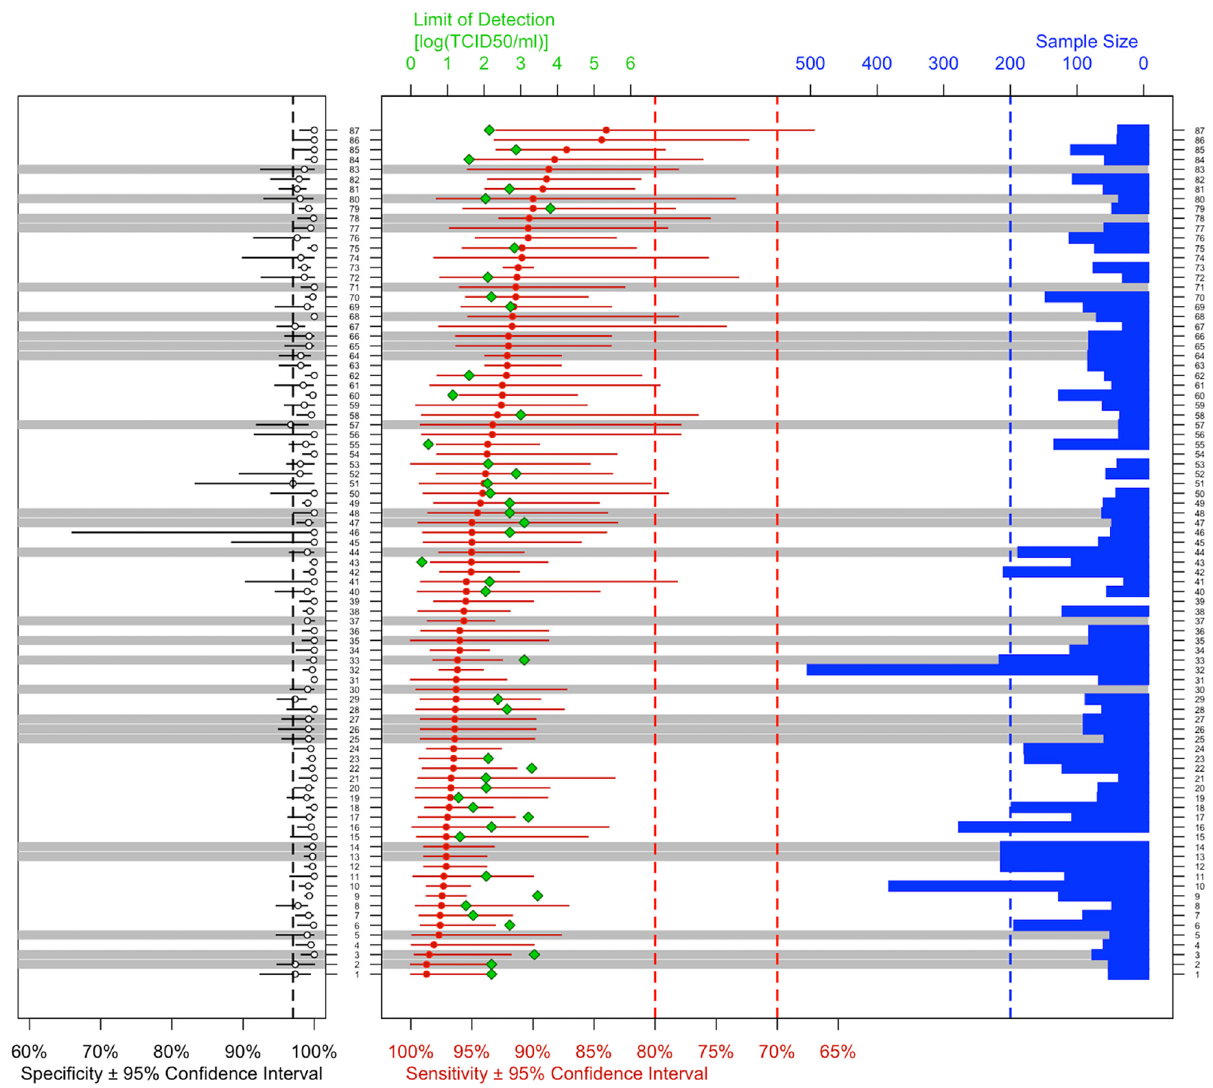
Figure 1: Graphical representation of clinical performance data of non-identical SARS-CoV-2 rapid tests (n=87). Dataondiagnosticsensitivity( ● ,redcircles)andspecificity( ○ ,blackcircles)weretakenfromthelistofapplicableSARS-CoV-2antigenrapid tests of the BfArM [2] (as of 17.11.2020). Provider information on the size of the tested collectives ( ■ , blue bars) and the detection limit ( � , green diamonds) were available for 77 and 46 SARS-CoV-2 antigen rapid tests, respectively. The dashed vertical lines correspond to the default values [11] for diagnostic sensitivity (red), speci fi city (black), and sample size (blue). Vertical lines represent the 95% con fi dence intervalsdeterminedbytheprovider.Provider ’ sdata oncon fi denceintervalsthatdidnotappearplausibleaftervisualinspectionofthegraph were recalculated. The corrected values are shown in the Figure. Areas highlighted in grey indicate test ID ’ s that were removed from the list after the closing date of